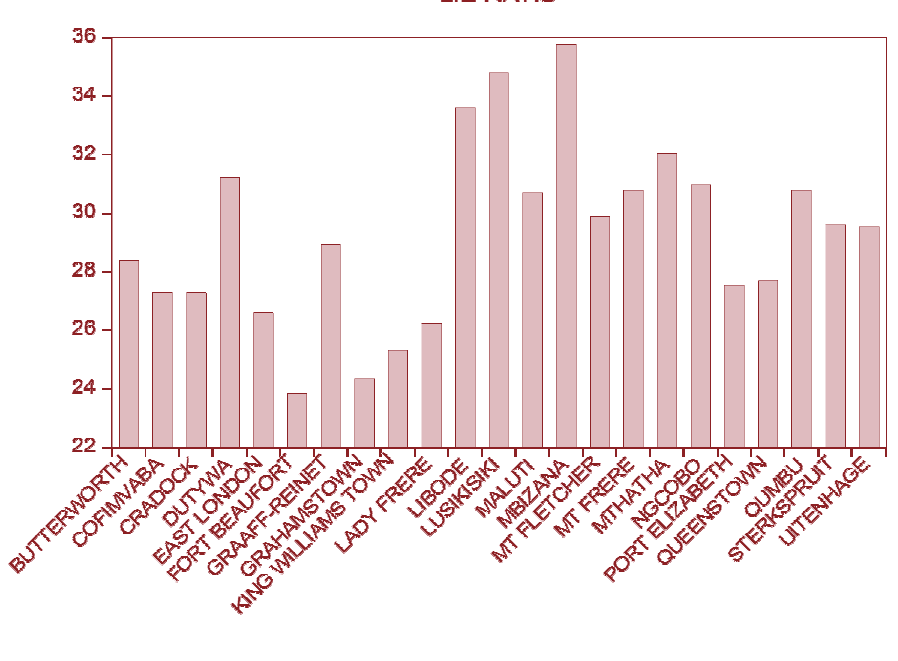
Figure 6: Educator learner ratios per district, 2009